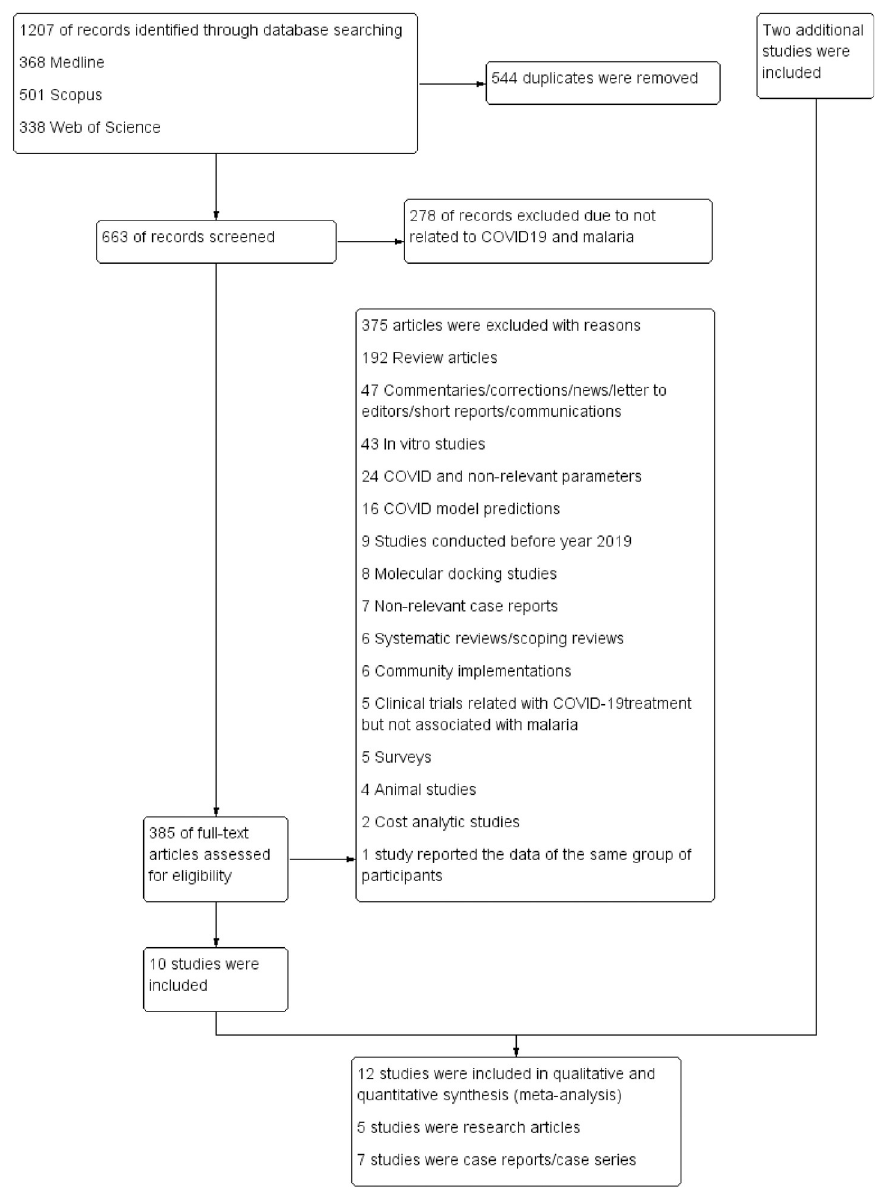
Fig 1. Flowchart for the selection of potentially relevant studies for use in the present